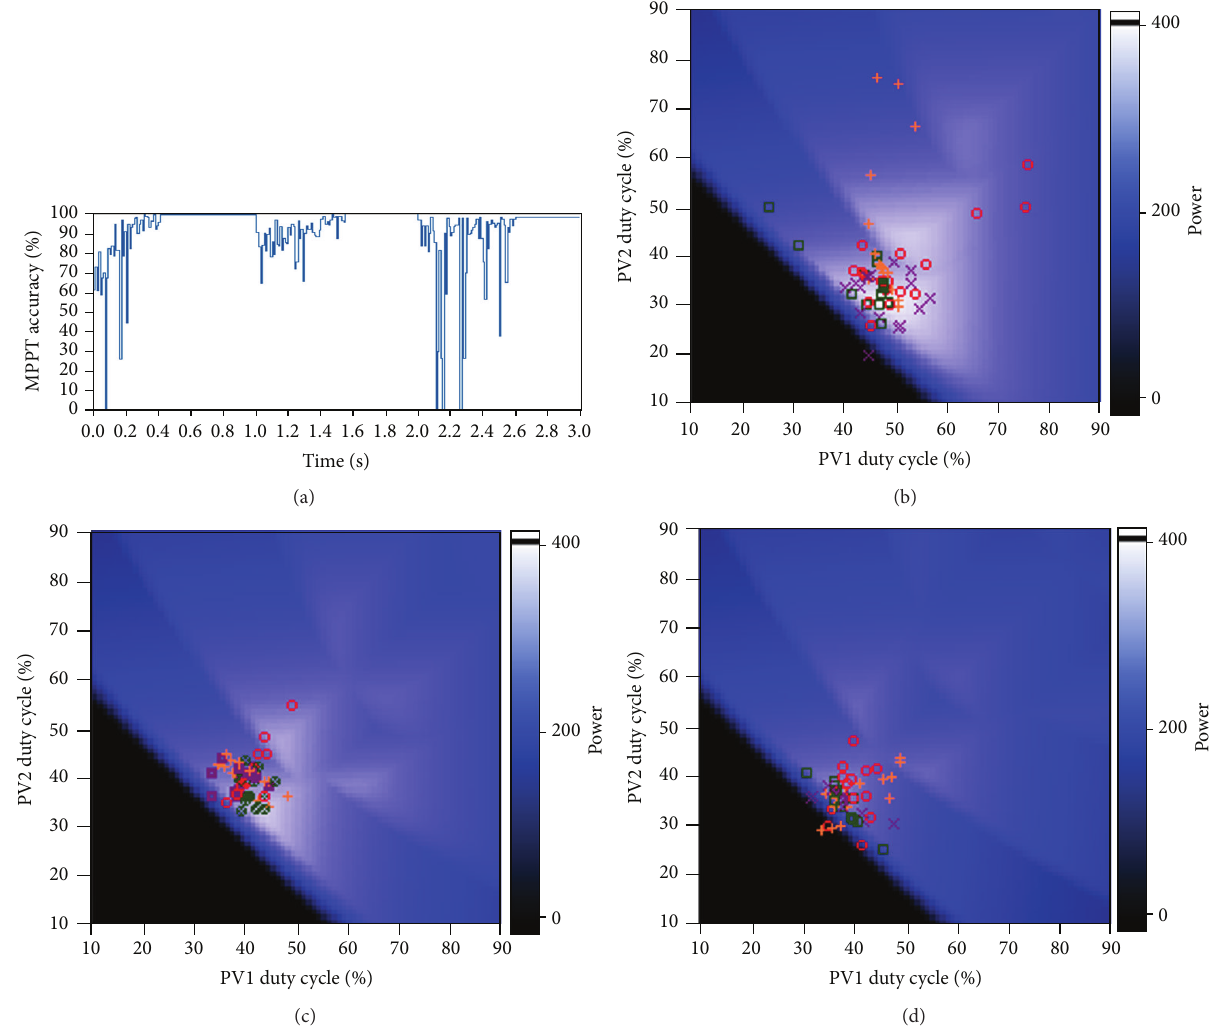
Figure 12: PSO tracking result from partial shading Case 3 to Case 5 to Case 6 : (a) MPPT accuracy calculation; (b) agent movement from track start to maximum power output on Case 3 ; (c) agent movement from Case 3 to Case 5 ; (d) agent movement from Case 5 to Case 6 .